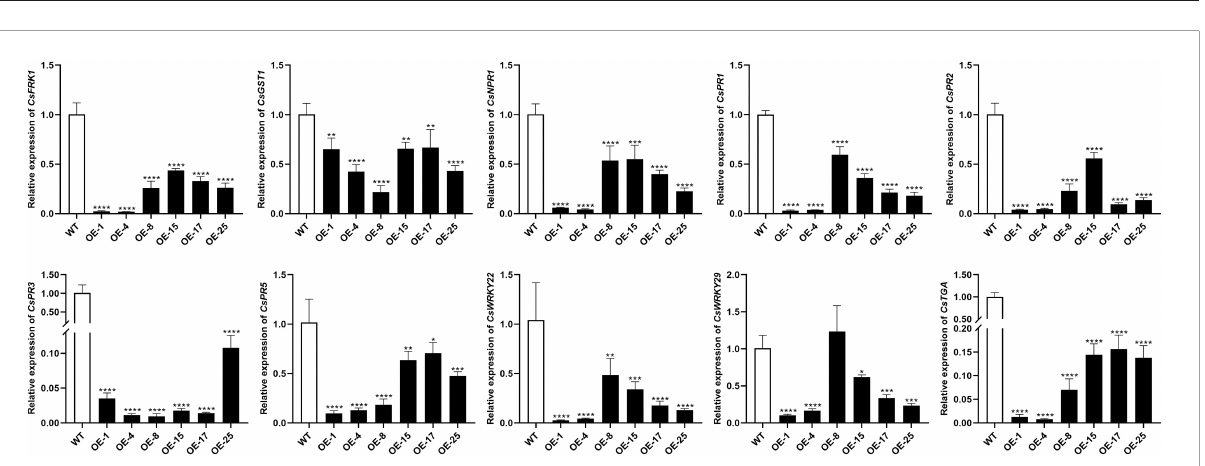
FIGURE5 mSECP8 down-regulated the expression of defense-related genes in transgenic citrus. Transcript level of CsFRK1 , CsGST1 , CsNPR1 , CsPR1 , CsPR2 , CsPR3 , CsPR5 , CsWRKY22 , CsWRKY29 , and CsTGA were significantly lower in mSECP8 -transgenic than that in WT Wanjincheng plants. The CsActin gene was used as an endogenous control. The asterisks indicate significant difference (* P < 0.05, ** p < 0.01, *** P < 0.001 and **** P < 0.0001, one-way ANOVA with Dunnett’s test). The experiment comprised at least three independent biological replicates and three technical